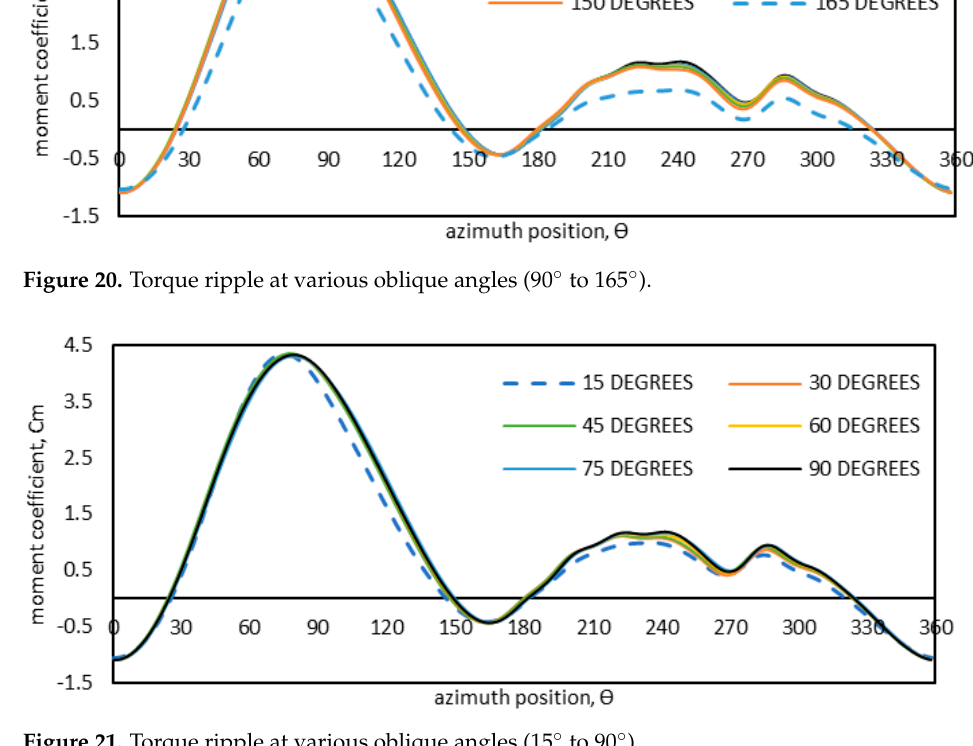
Figure 21. Torque ripple at various oblique angles (15° to 90°).